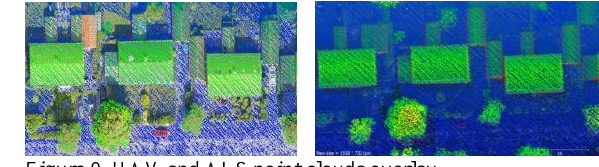
Figure 9. UAV and ALS point clouds overlay